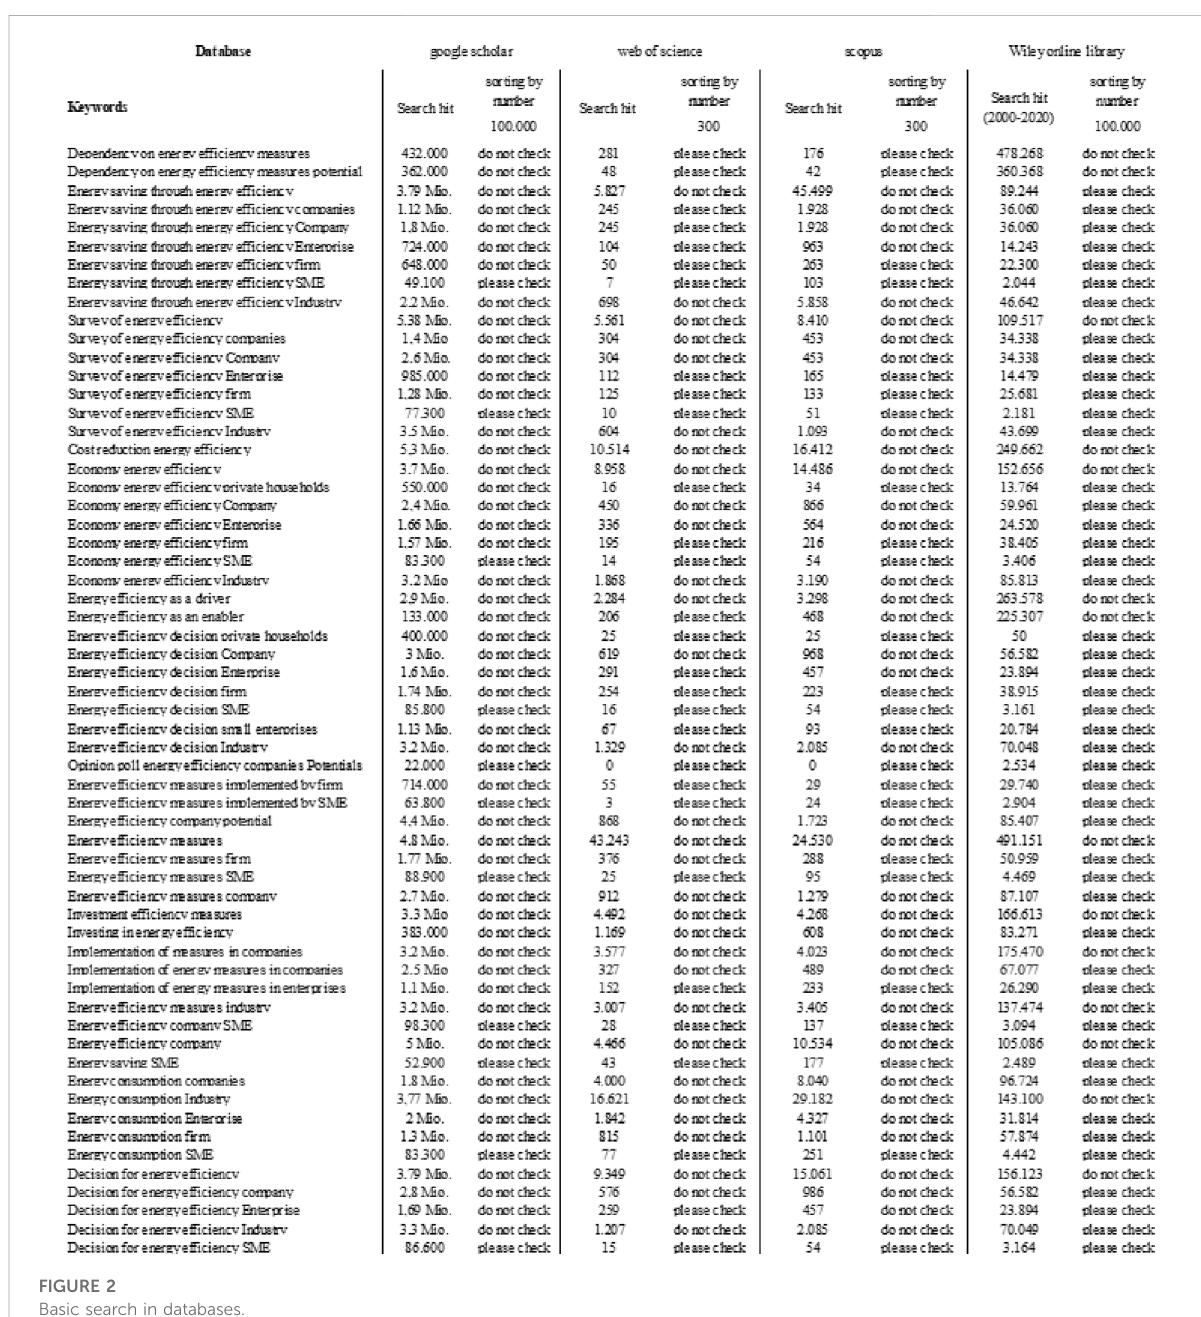
FIGURE 2 Basic search in